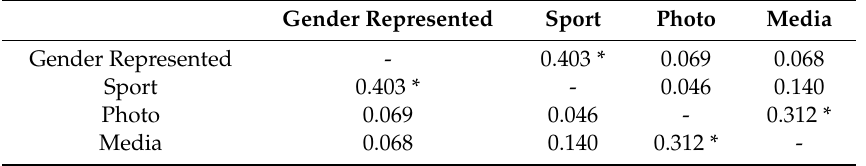
Table 3. p values corresponding to the χ 2 Tests of Independence of the variables “gender represented”, “sport”, “photo” and “media”. Gender Represented Sport Photo Media Gender Represented - 0.000 ** 0.000 ** 0.000 ** Photo 0.000 ** Media